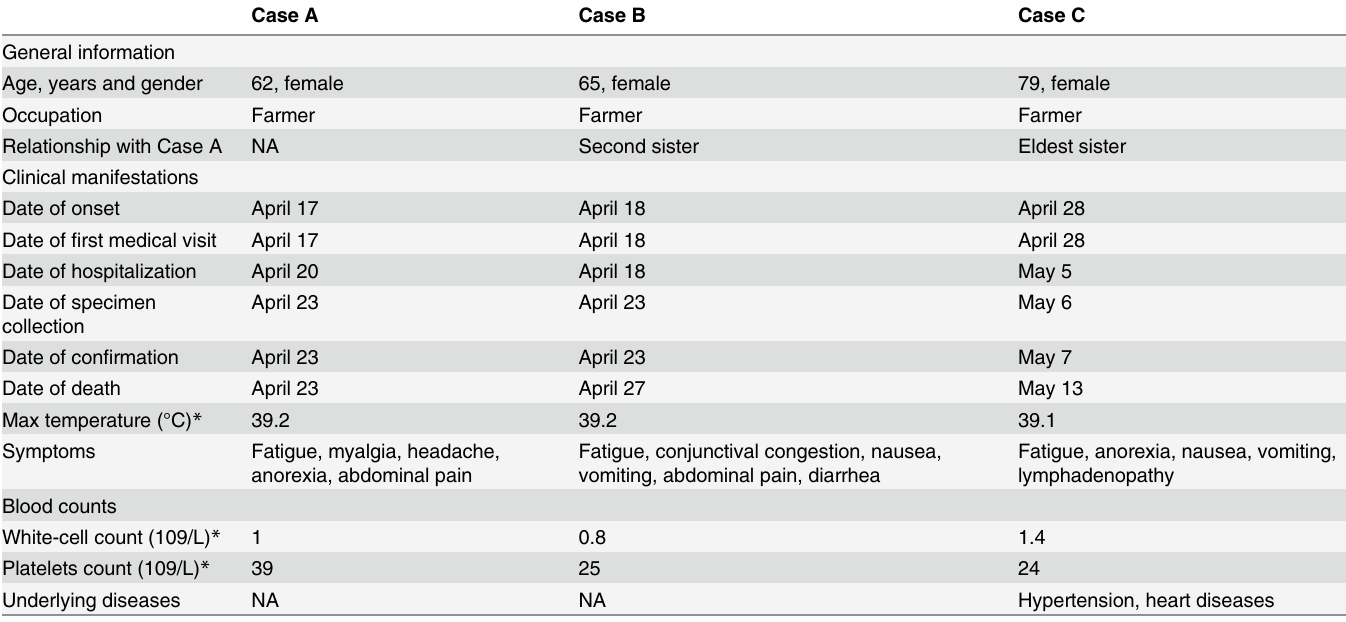
Table 1. The Clinical features of patients involved in a family cluster occurred in 2014, Southeastern China.